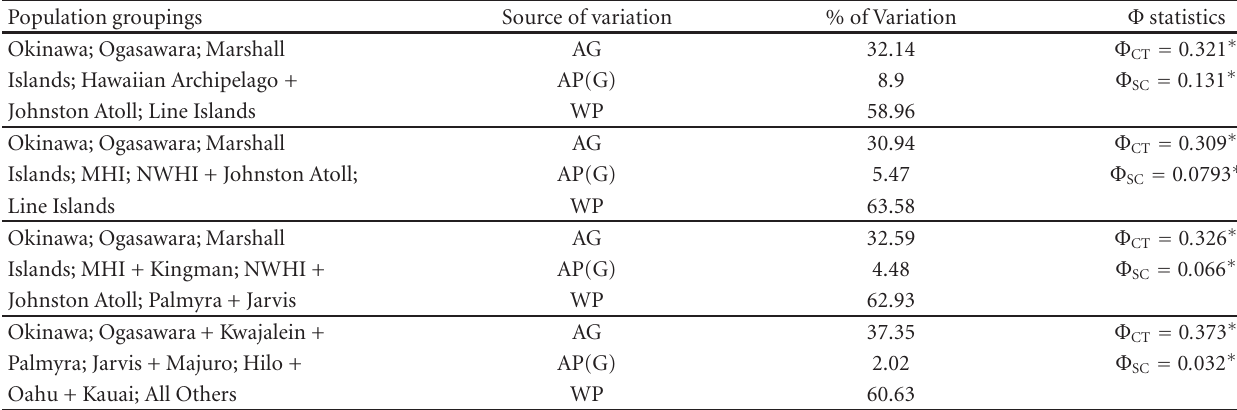
Table 3: Analysis of molecular variance (AMOVA) for di ff erent population groupings. Beginning at the top, groupings are as follows: (1) by archipelago, (2) by archipelago with Hawaii divided between the Northwest Hawaiian Islands (NWHI) and the Main Hawaiian Islands (MHI), (3) six groups chosen by BARRIER and (4) six groups chosen by SAMOVA.